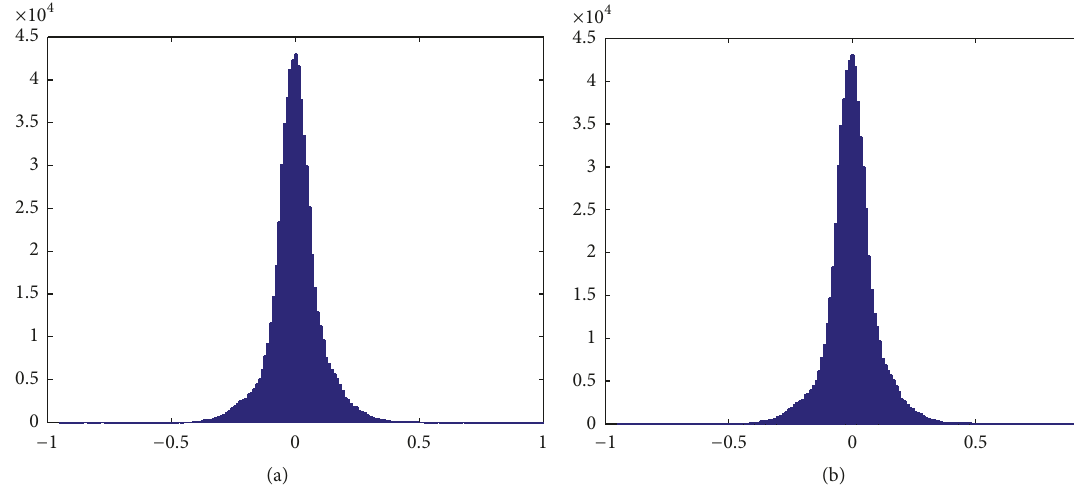
Figure 10: Correlation distributions of original and embedded sounds.